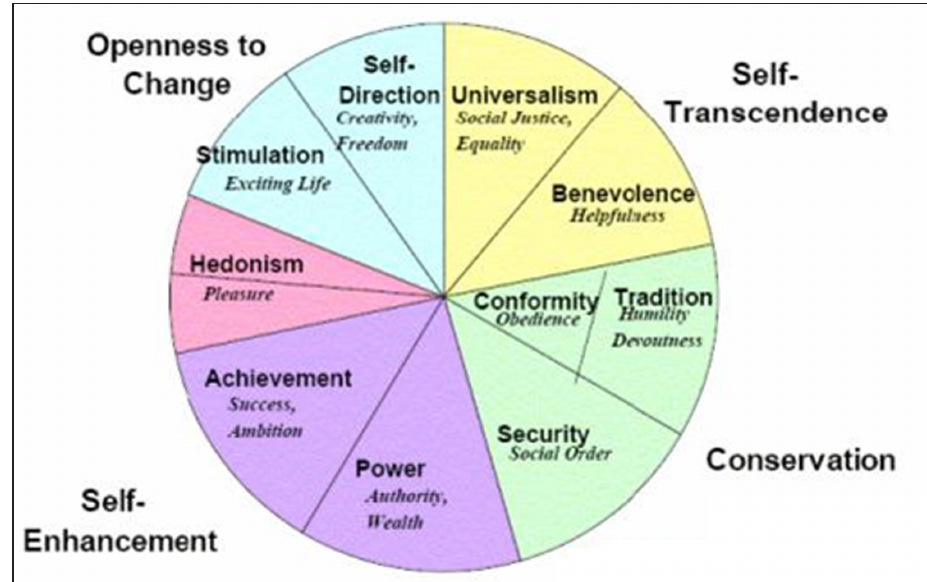
Figure 1 The set of ten values all individuals share according to the theory of basic human values (Schwartz, 1992) and their corresponding four higher-order values, which constitute two bipolar